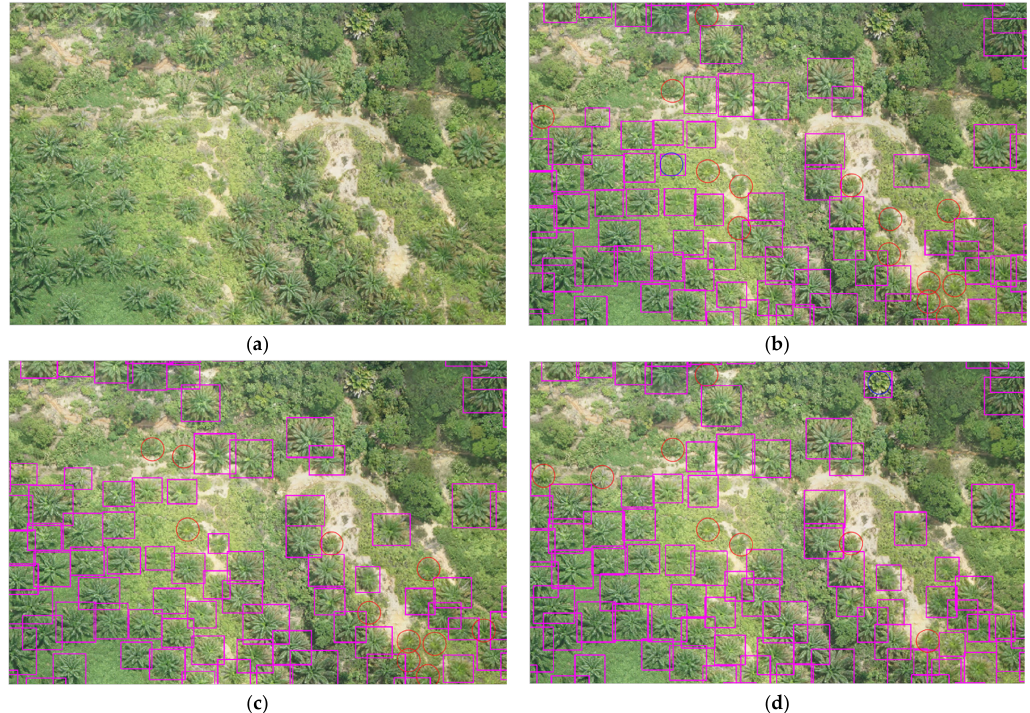
Figure 17. Oil palm trees with stressed growth: ( a ) Original image; ( b ) YOLOv3 detection; ( c ) YOLOv4 detection; ( d ) YOLOv5m detection.